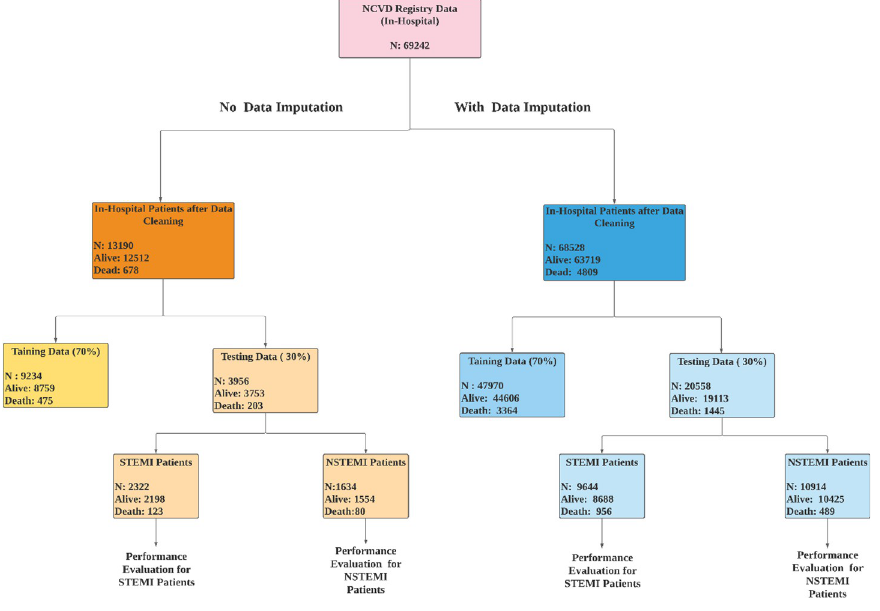
Fig 1. Study data